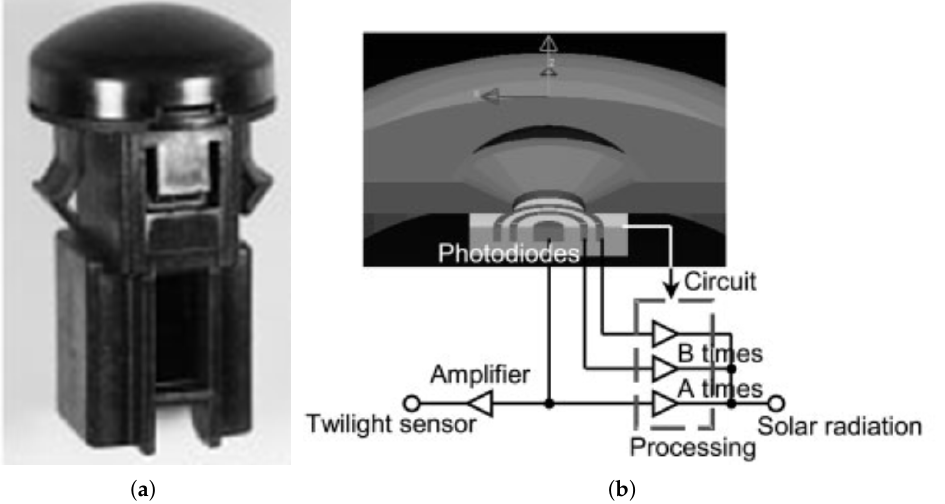
Figure 7. Dual light sensors: ( a ) dual light sensors, and ( b ) circuit for dual light sensors.